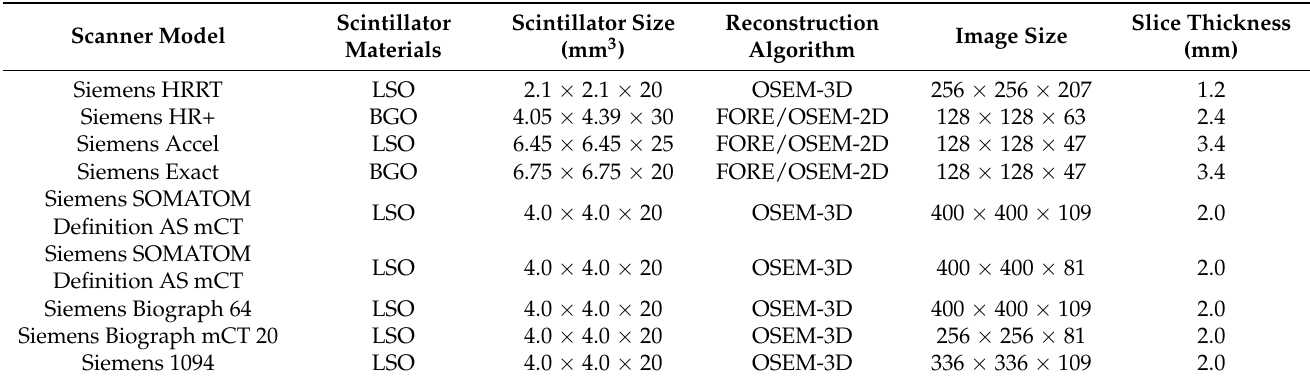
Table 4. Scanner models and inter-scanner differences in the 18 F-FDG-PET